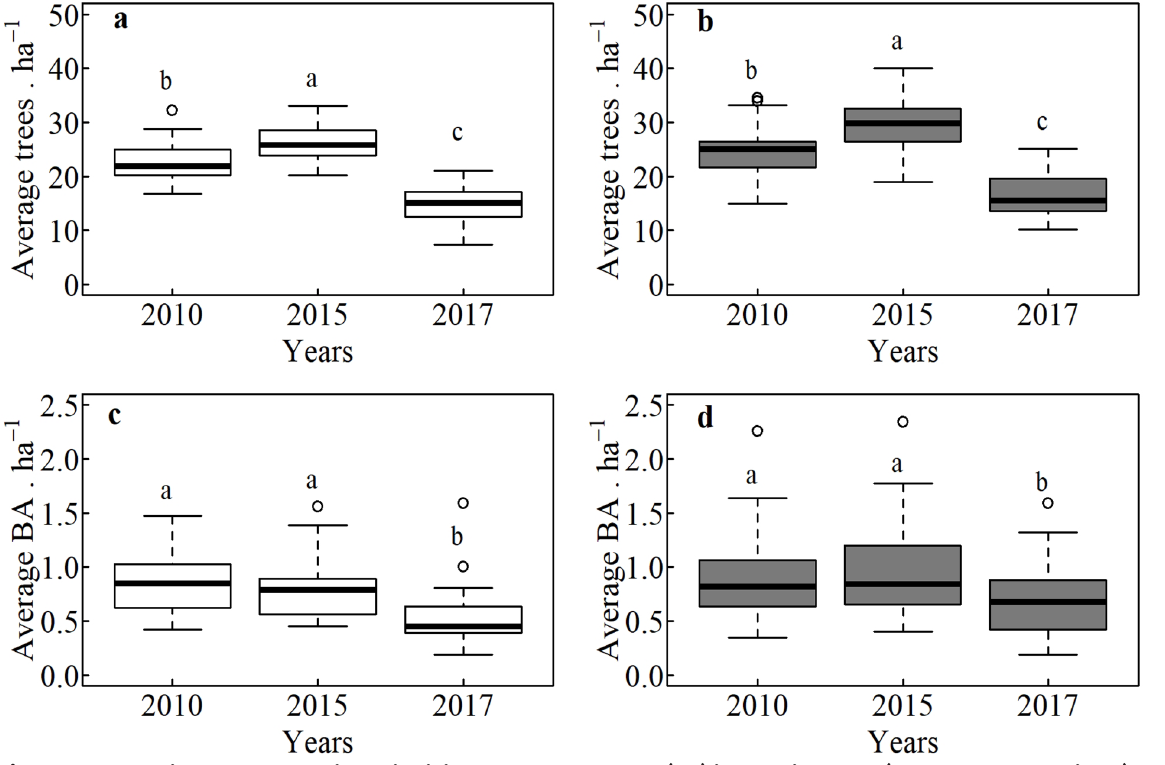
Figure 4. Comparison of the density of individuals and basal area (BB) in the disturbed (3a and 3c, respectively) and undisturbed forest (3b and 3d, respectively) over the years, Tapajós National Forest, Pará, Brazil. Different lower-case letters indicate statistical difference, the Tukey test was performed at 0.05 level of